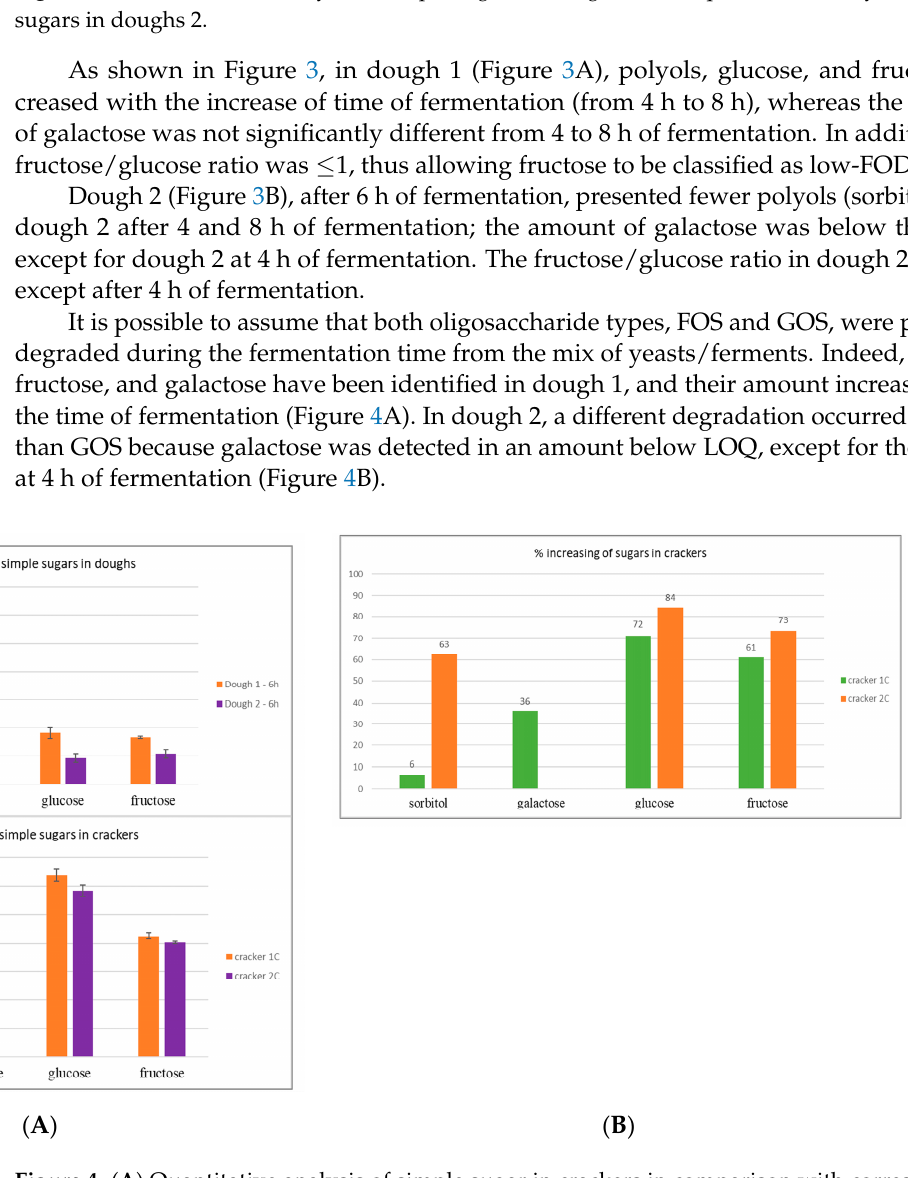
Figure 4. ( A ) Quantitative analysis of simple sugar in crackers in comparison with corresponding doughs; ( B ) % increase of simple sugars in crackers compared with the corresponding